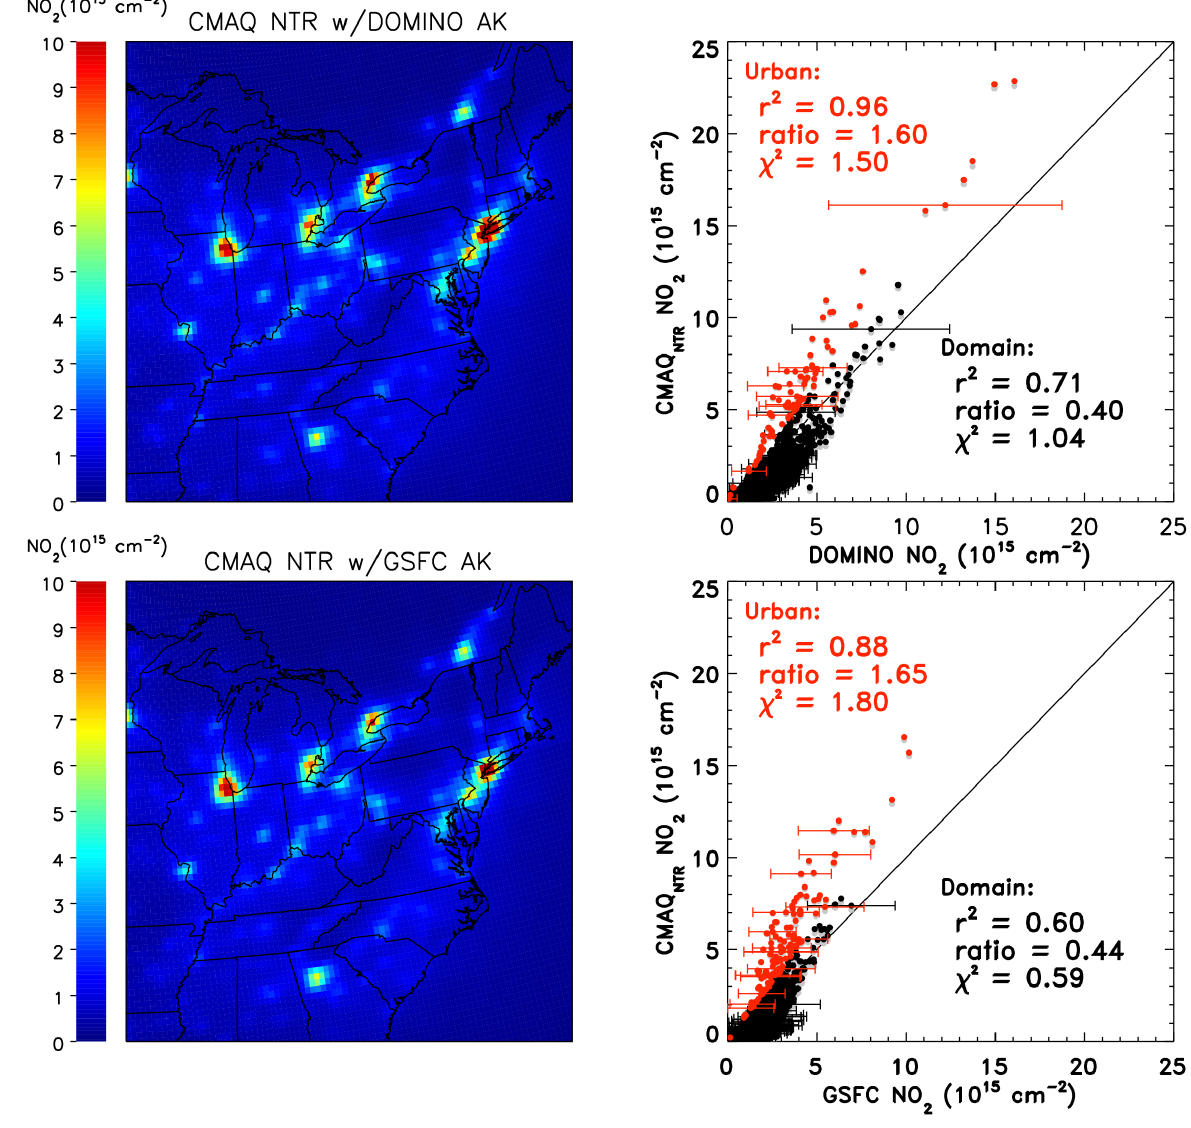
Figure 5. Similar to Fig. 2 except the chemical mechanism in the CMAQ model has been modified such that the lifetime of NTR is reduced by a factor of 10 (CMAQ NTR ). Gray points on the scatter plots represent the results shown in Fig. 2 (right panels). As in Fig. 3, red points represent urban